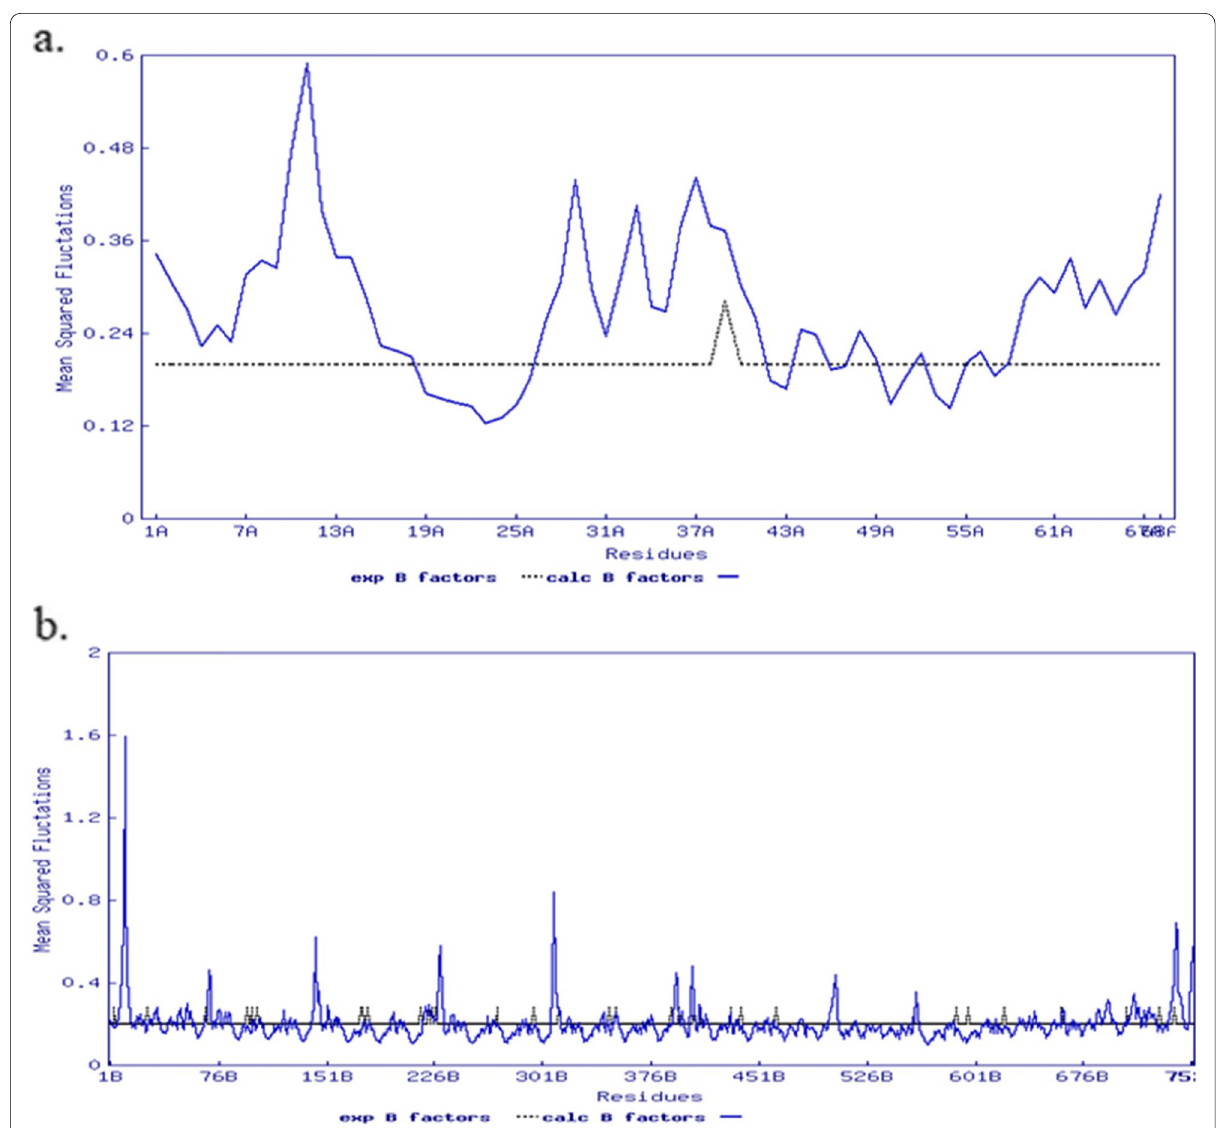
Fig. 8 Molecular dynamics of docked complex.